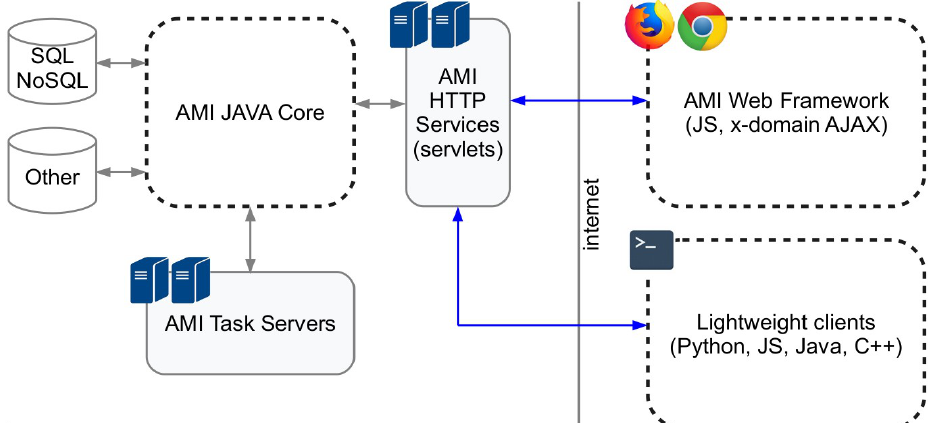
Fig. 1. Overview of the AMI